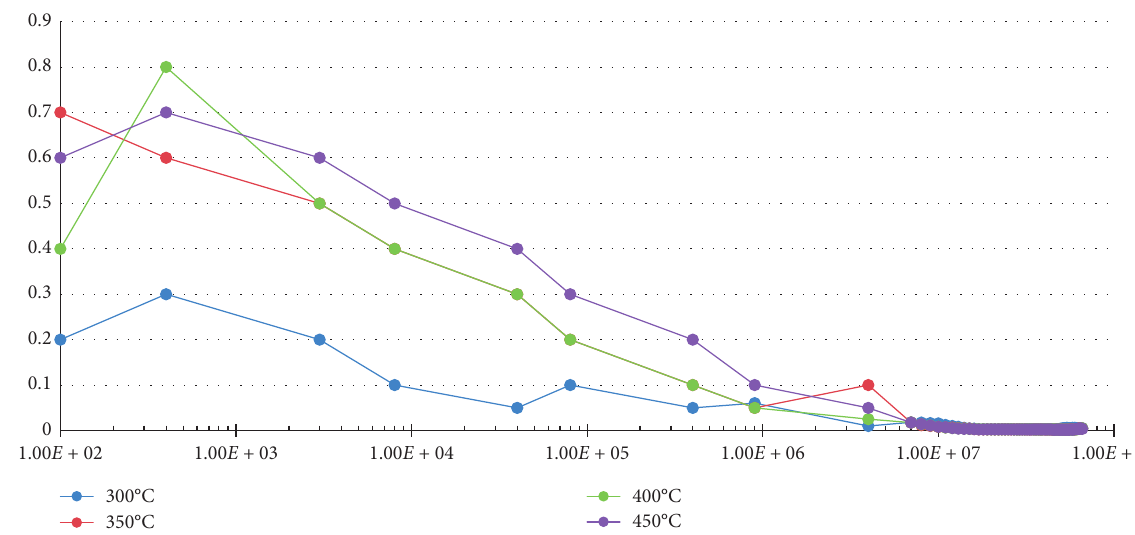
Figure 9: The dielectric loss of SnO 2 powders with different calcination temperatures as a function of driven frequencies.